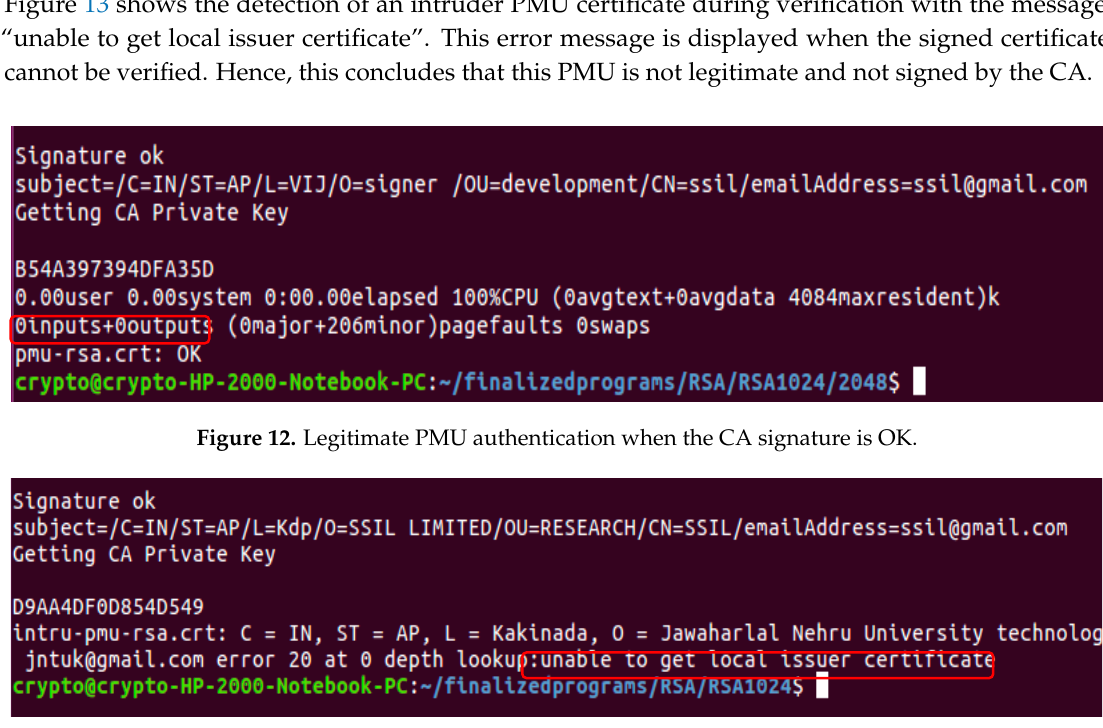
Figure 13. Intruder PMU signature verification fail.